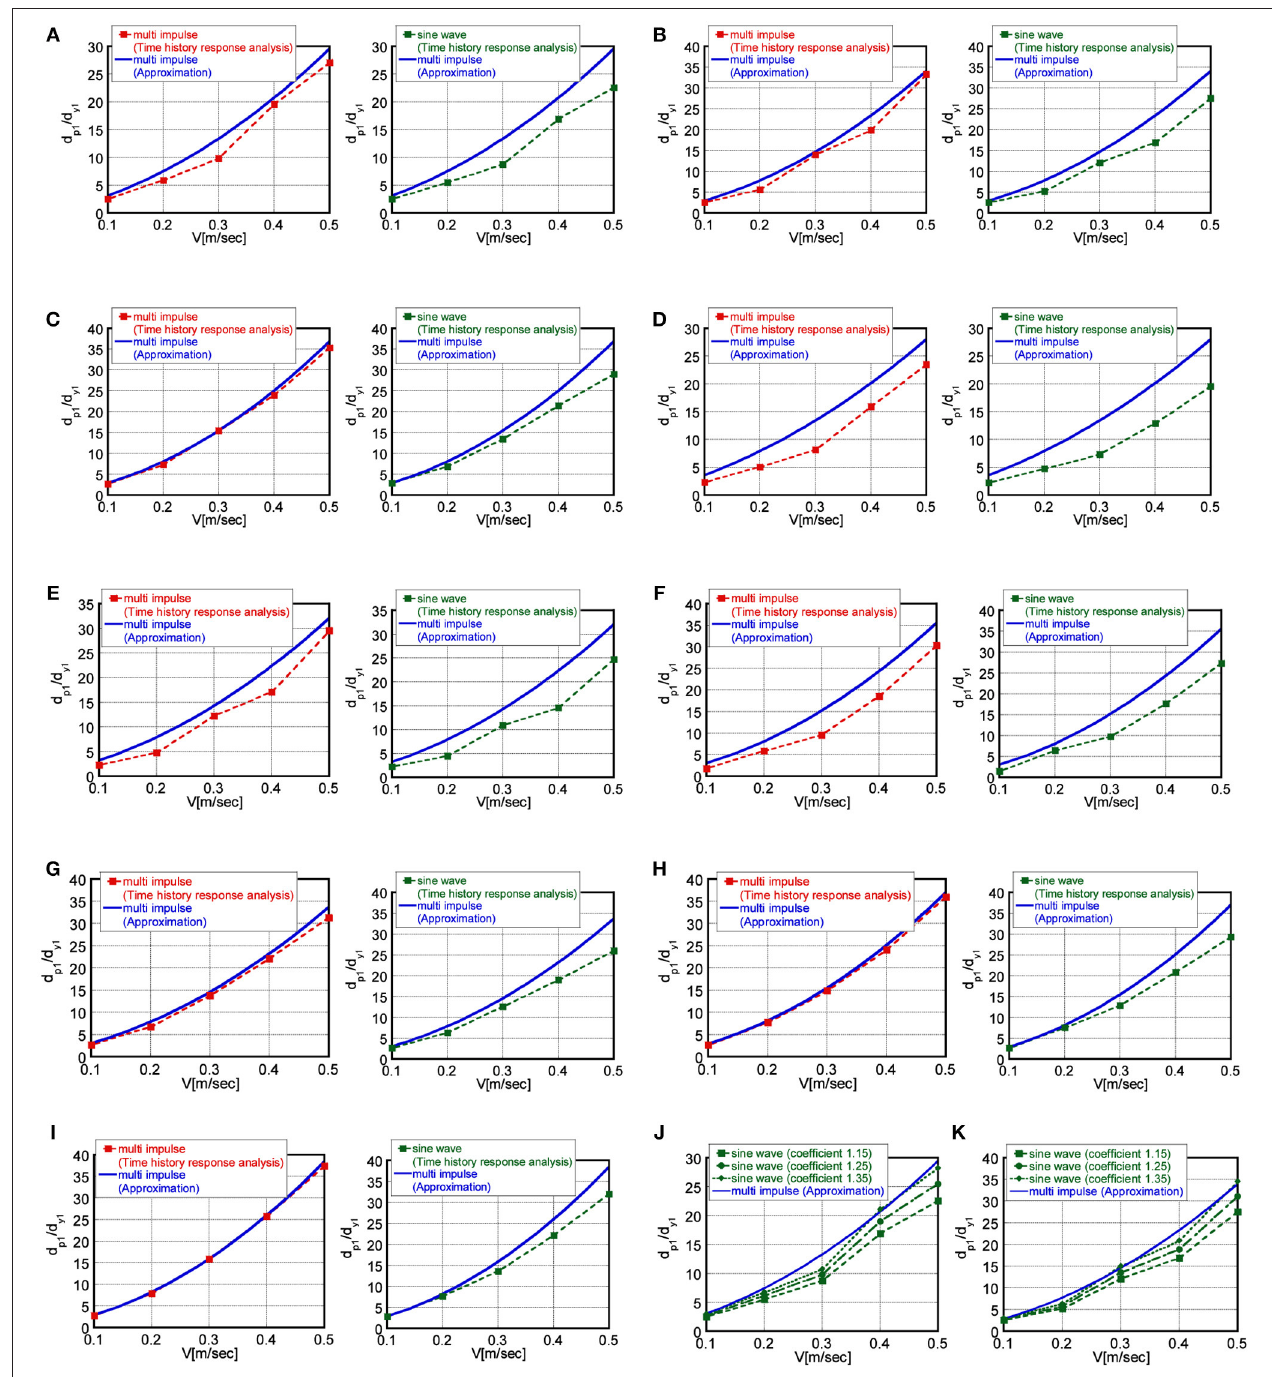
FIGURE 9 | Comparison of plastic deformation amplitude under critical multiple impulse (approximate solution and time-history response analysis) and that under corresponding multi-cycle sinusoidal wave (time-history response analysis); (A) m 1 : m 2 = 1 : 1, k 1 : k 2 = 2 : 1, (B) m 1 : m 2 = 1 : 1, k 1 : k 2 = 1 : 1,